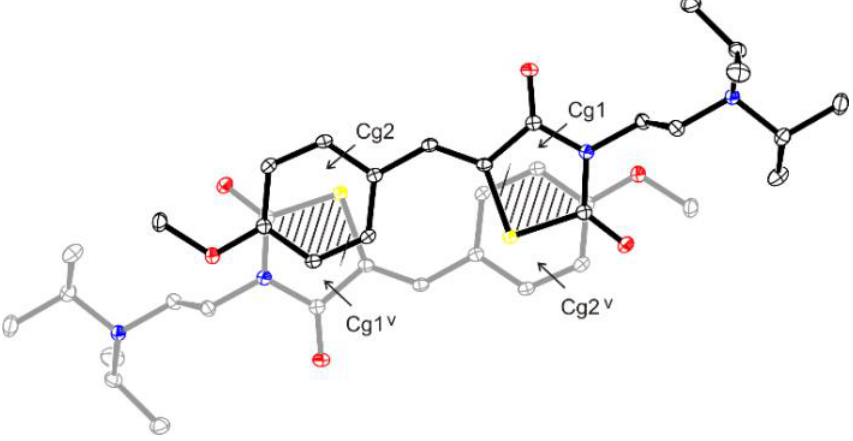
Figure 5. π ··· π Interactions between thiazolidin-2,4-dione ( Cg 1) and phenylene ( Cg 2) systems. Hy- drogen atoms have been omitted for clarity. Symmetry code : (v) 1/2 − x,1/2 − y,1 − z.